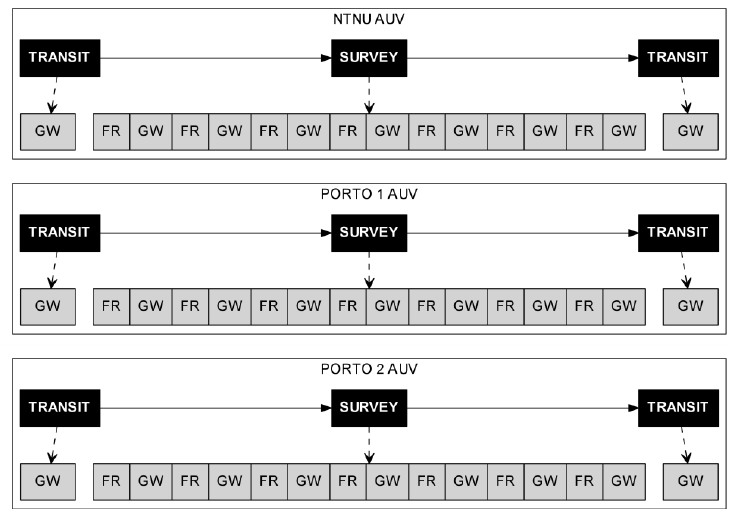
Figure 4. Example of a mission for three autonomous underwater vehicles (AUVs) named NTNU, PORTO 1 and PORTO 2. In this figure GW refers to the low-level task GOTO-WAYPOINT , and FR , refers to the low-level task FOLLOW_ROW .